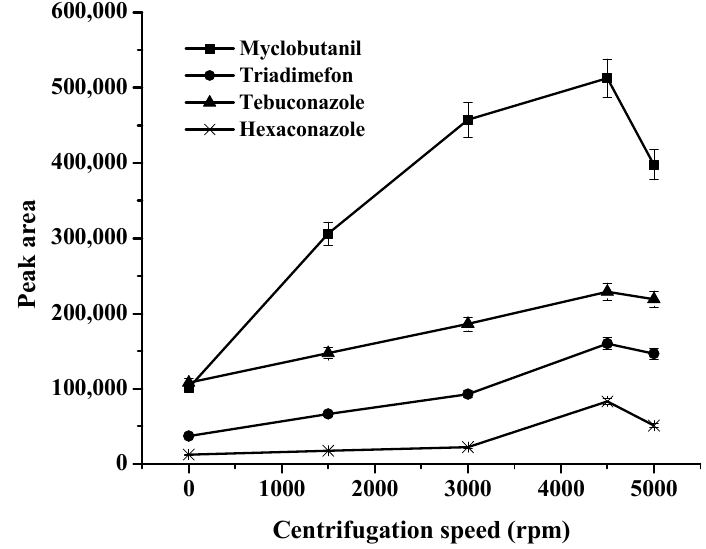
Figure 4. Effects of centrifugation speed (rpm) on the extraction efficiency.